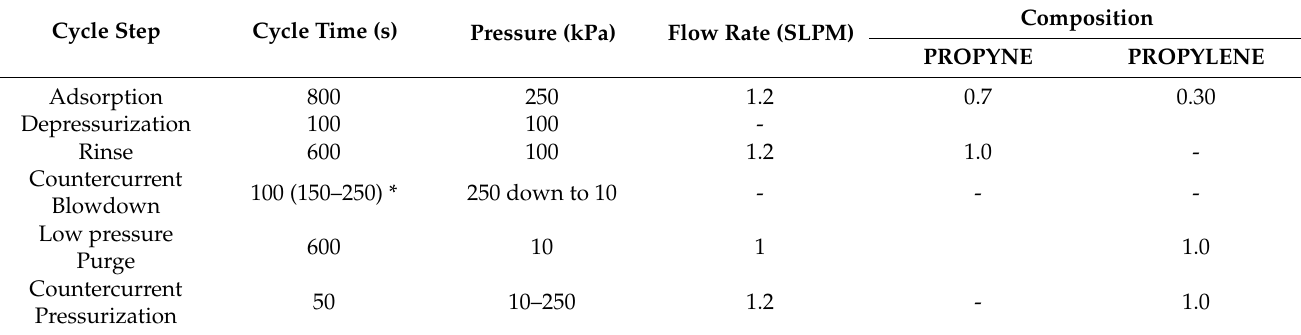
Figure 3. Schematic showing the full VSA cycle configurations used. Table 1. Experimental operating conditions for typical vacuum pressure swing (VPS)